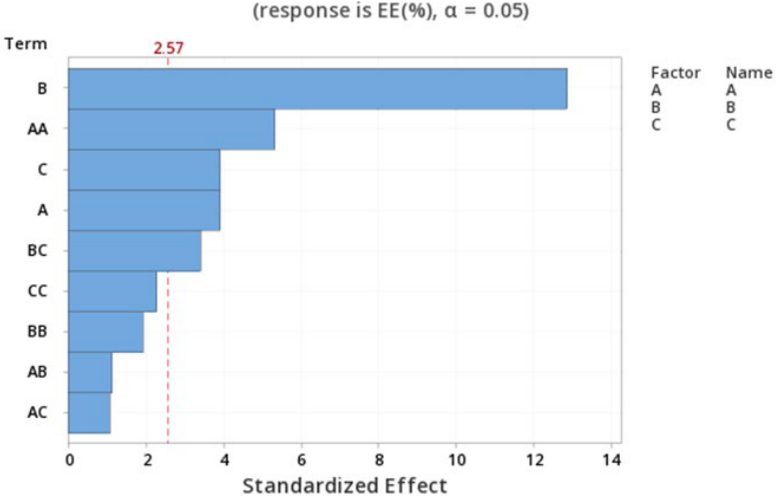
Figure 6. Pareto chart expressing the standardized effect of independent variables and their interac- tion on the EE% of the NPs. The relationship between the independent and dependent variables was further highlighted by plotting surface and contour plots. It was de termined from the contour and surface plots (Figure 7e,f) that an EE of 70.00% or higher could be obtained with a B range from − 1 to 1 level and a C range from −0.9 to 1 level. The highest significant effect was shown to be the amount of drug, with the highest percent of contribution of 67.71%.